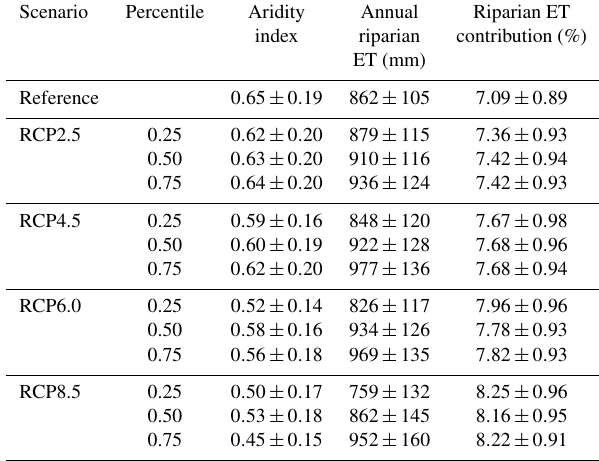
Table 4. Aridity index, annual riparian evapotranspiration (ET) rates, and relative contribution of riparian ET to annual catchment water depletions (i.e., upland ET + riparian ET + streamflow) for the reference period (1981–2000) and for each RCP scenario during the future period (2081–2100). Values are mean ± standard